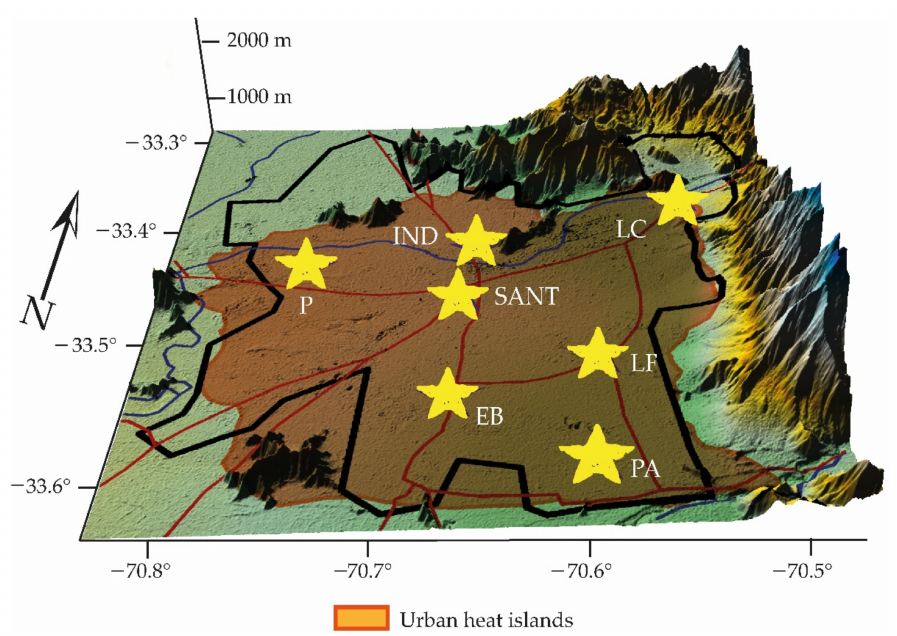
Figure 3. RM communal map with the approximate location (darkest area) of the thermal island (SANT: Santiago, LC: Las Condes, LF = La Florida, PA = Puente Alto, P = Pudahuel, EB = El Bosque, IND =